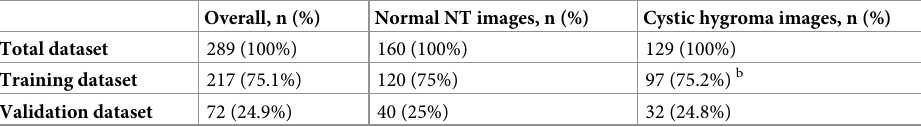
Table 1. Partitioning of data across training and validation datasets a .